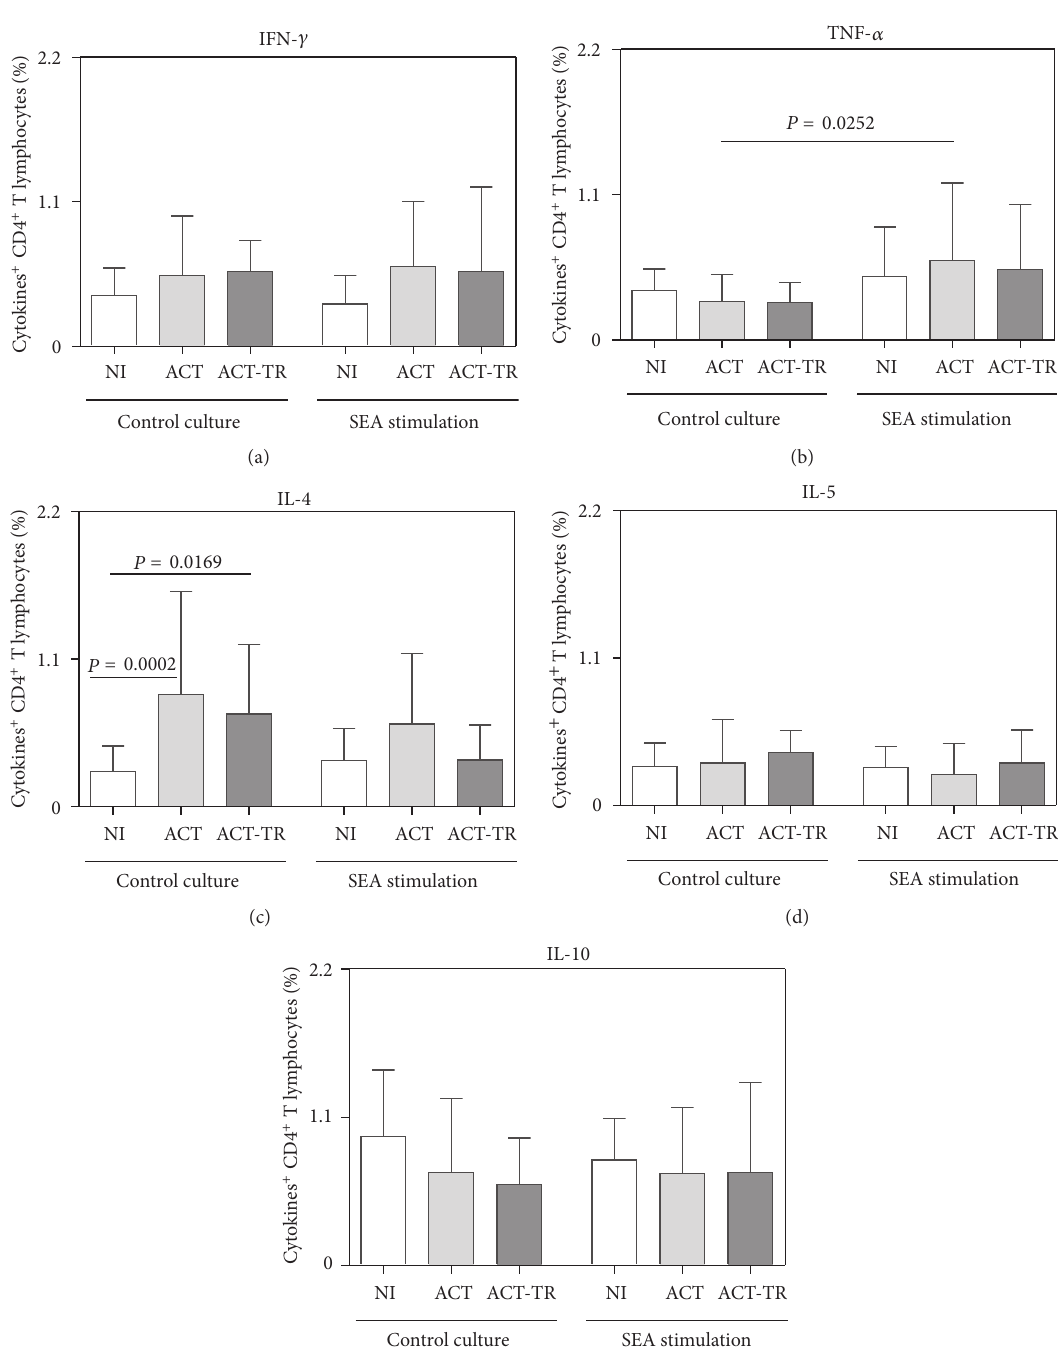
F 3: Cytokine pattern of circulating T CD4 -lymphocytes from patients with acute Schistosomiasis mansoni before (ACT, faint grey square = 21) and aer praziquantel treatment (ACT-TR, grey square = 07) and noninfected individuals (NI, white square = 19), following + short-term in vitro cultivation in the absence (control culture) or presence of SEA stimulation. e results are shown in bar-plot format highlighting the mean percentage of datasets standard deviation. Statistically signi�cant di�erences (connecting lines) observed between groups NI, ACT, and ACT-TR were considered at ± 𝑃𝑃 𝑃 𝑃𝑃𝑃𝑃